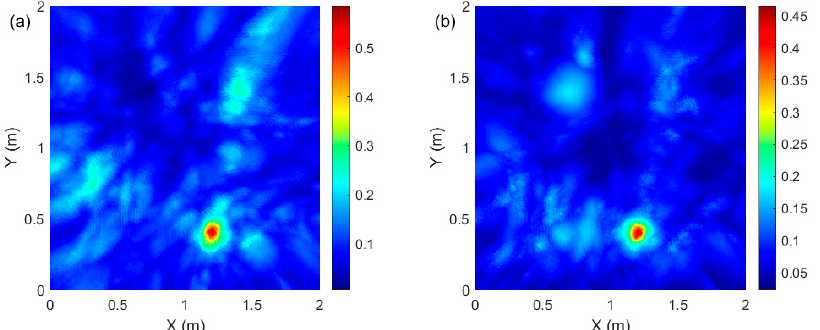
Figure 7. DAS Beamforming maps after removing s 1 . ( a ) Without DNNs; ( b ) with DNNs.